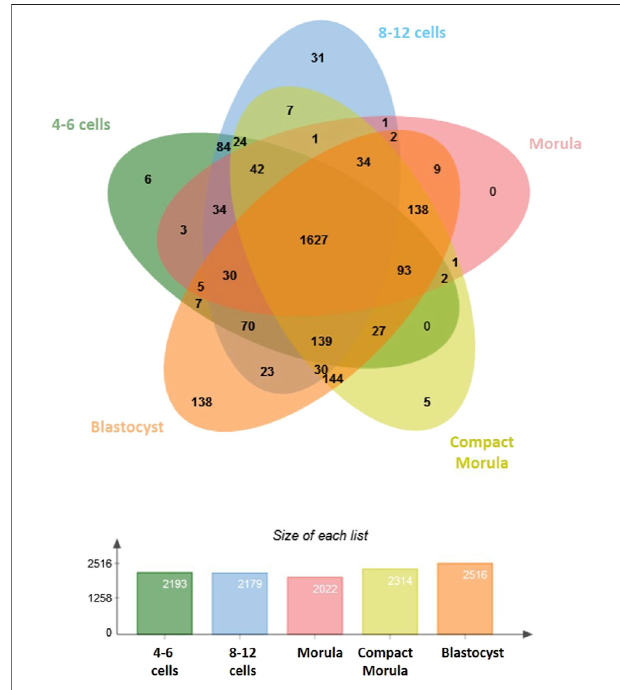
FIGURE 1 | Comparative analysis of proteins identi fi ed in bovine early embryos. Venn diagram showing the overlap among developmental stages and histogram showing numbers of proteins identi fi ed in each